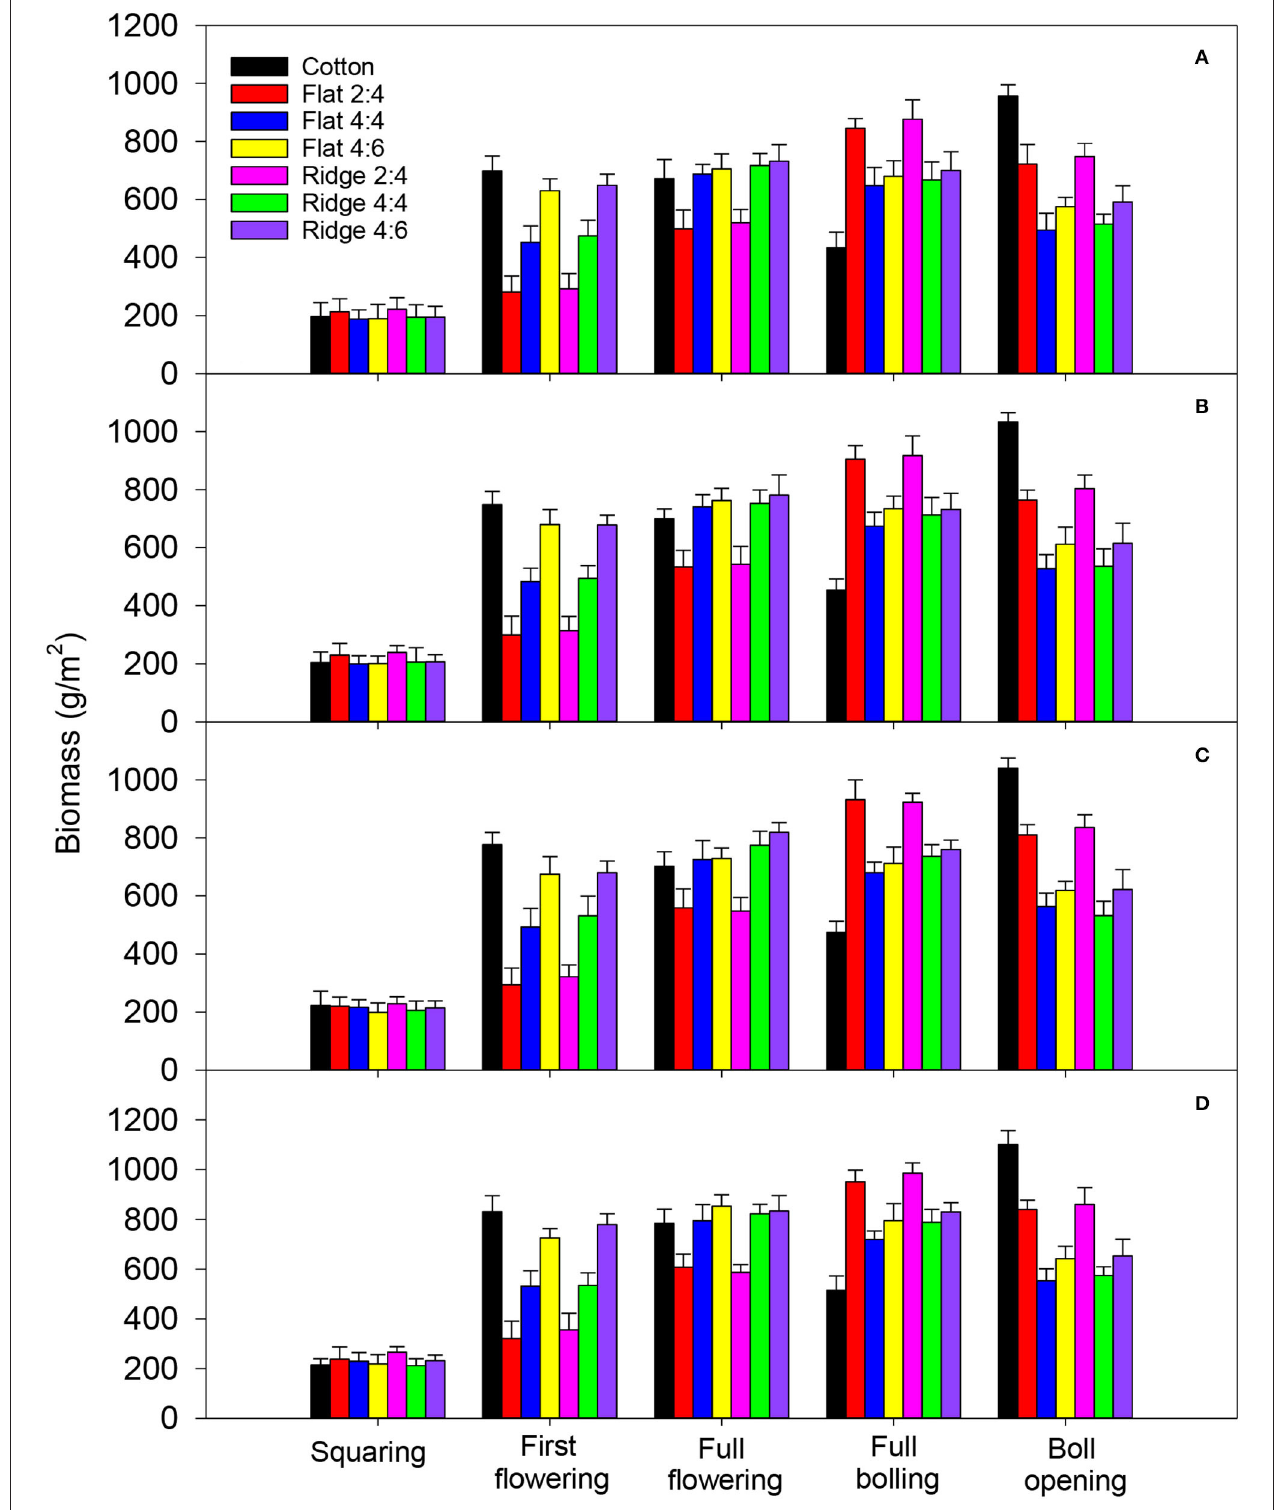
FIGURE 1 | Cotton biomass accumulation from 2018 to 2019 [ (A) 2018, Dongping; (B) 2018, Xiajin; (C) 2019, Dongping; (D) 2019, Xiajin].